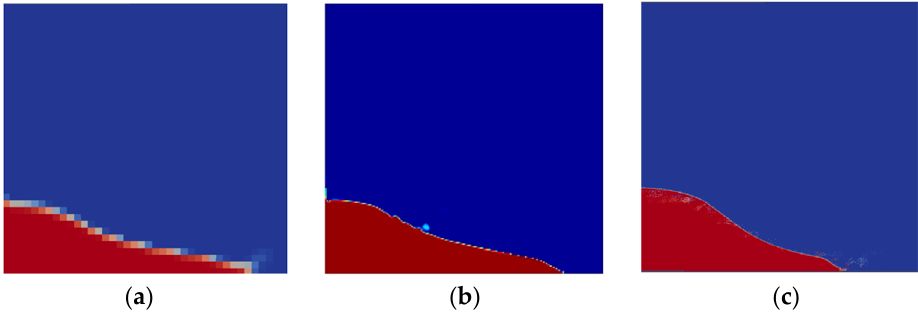
Table 3. Grid classification.